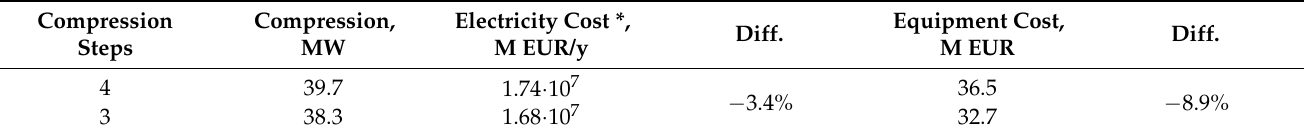
Table 4. Comparison of 3 and 4 stages for steelworks feedstock compression.